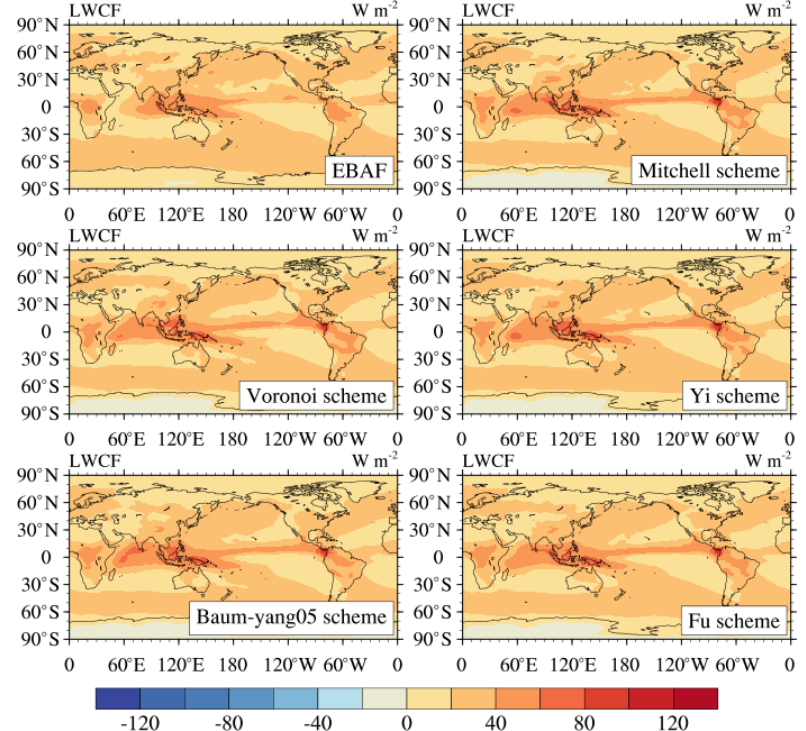
Figure 8. Same as the Fig. 7 but for TOA